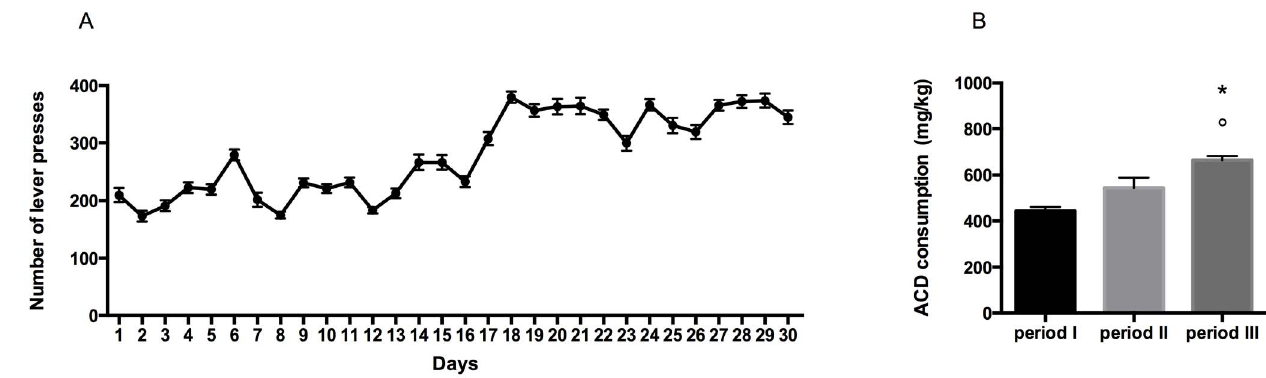
Figure 1. Operant drinking-behaviour pattern. Number of lever presses during the 30 days of training in the operant-drinking paradigm (A). ACD consumption (mg/kg) during subsequent periods of training in the operant-drinking paradigm. u p , 0.001 Vs period I; *p , 0.05 vs period II (B).